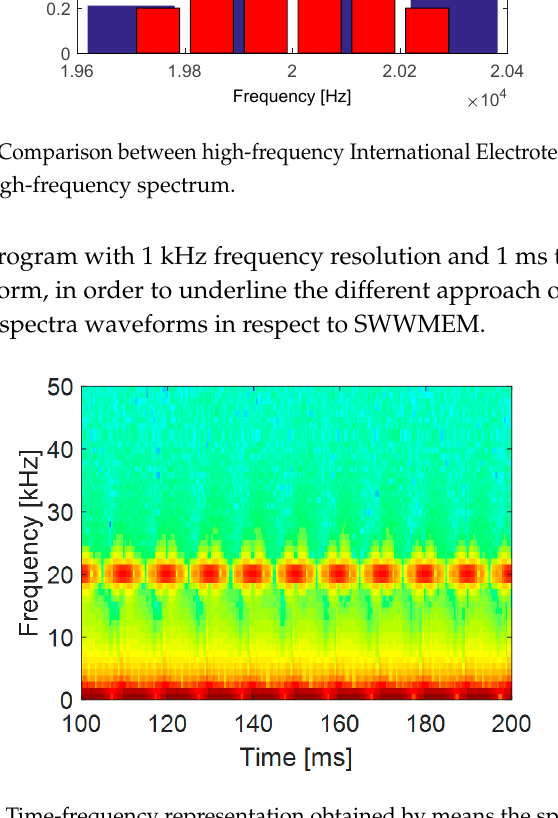
Table 2. Case study 1: computational times in per unit of computational time required by STFTM. Computational Time (p.u.)